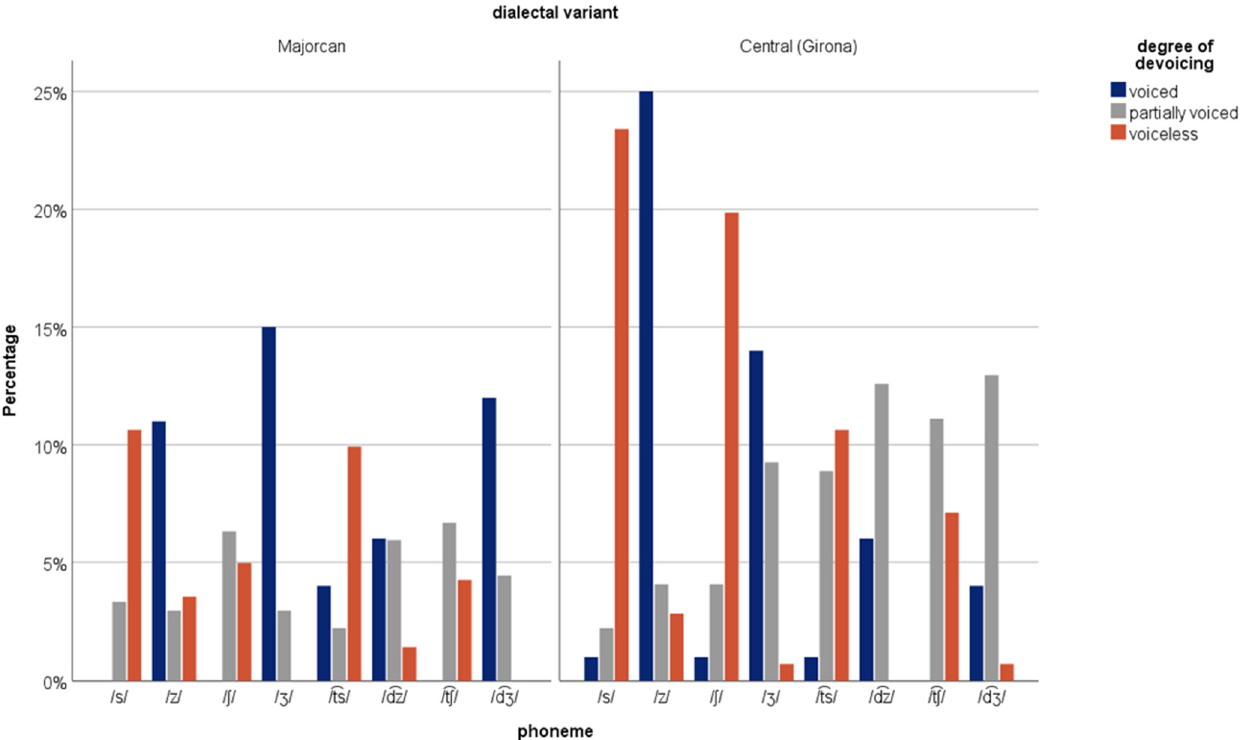
Figure 2. Bar plots showing the distribution of the three variants in Smith (1997) for each phonological category in Girona Central Catalan and in Majorcan Catalan.